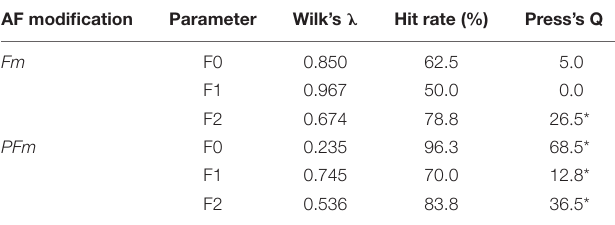
TABLE 2 | Summary of the discriminant analysis on all 40